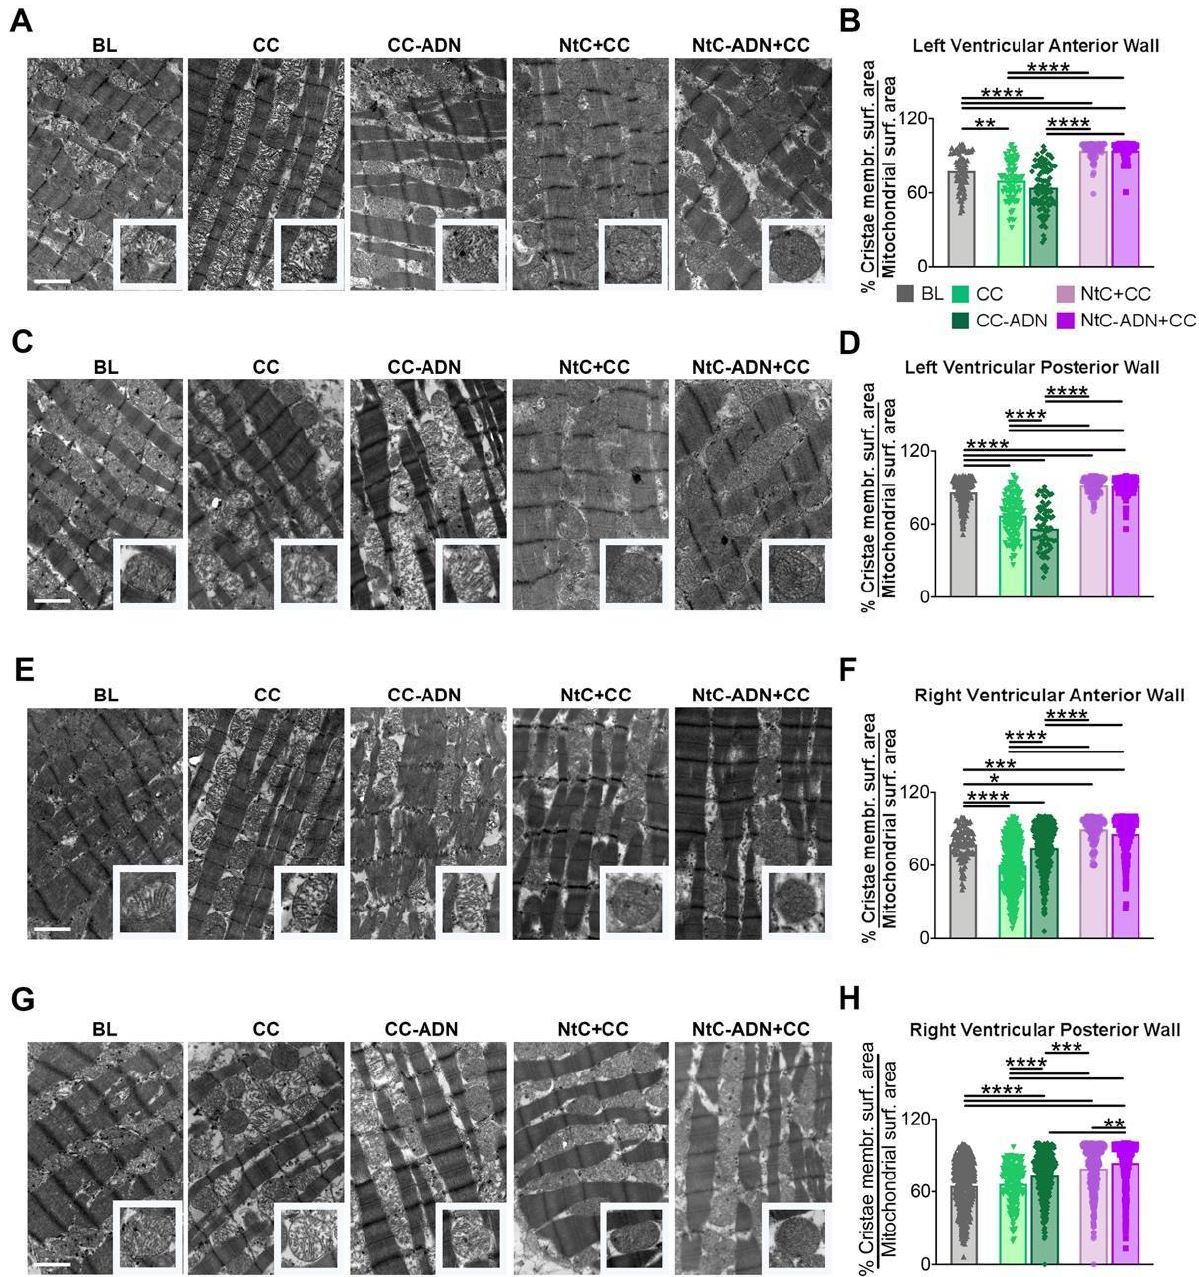
Figure 3. Mitochondrial morphology is preserved by NtC + CC treatment. ( A – G ) Transmission electron microscopy (TEM). Several heart regions of left and right ventricular were fixed, cut, and analyzed. Representative images are shown. Bars, 1 μm. Further statistical analyses on mitochondrial cristae are provided below in ( B , D , F ) and ( H ). A total of 30 images per area were analyzed. Values are shown as median ± range, n = 3. Note * p < 0.05; ** p < 0.01; *** p < 0.001; **** p < 0.0001. BL: baseline; CC: cardioplegia; CC-ADN: cardioplegia supplemented with adenosine; NtC + CC: 250 mL warm cardioplegia + 750 mL cold cardioplegia; NtC-ADN + CC: 250 mL warm cardioplegia supplemented with adenosine + 750 mL cold cardioplegia.